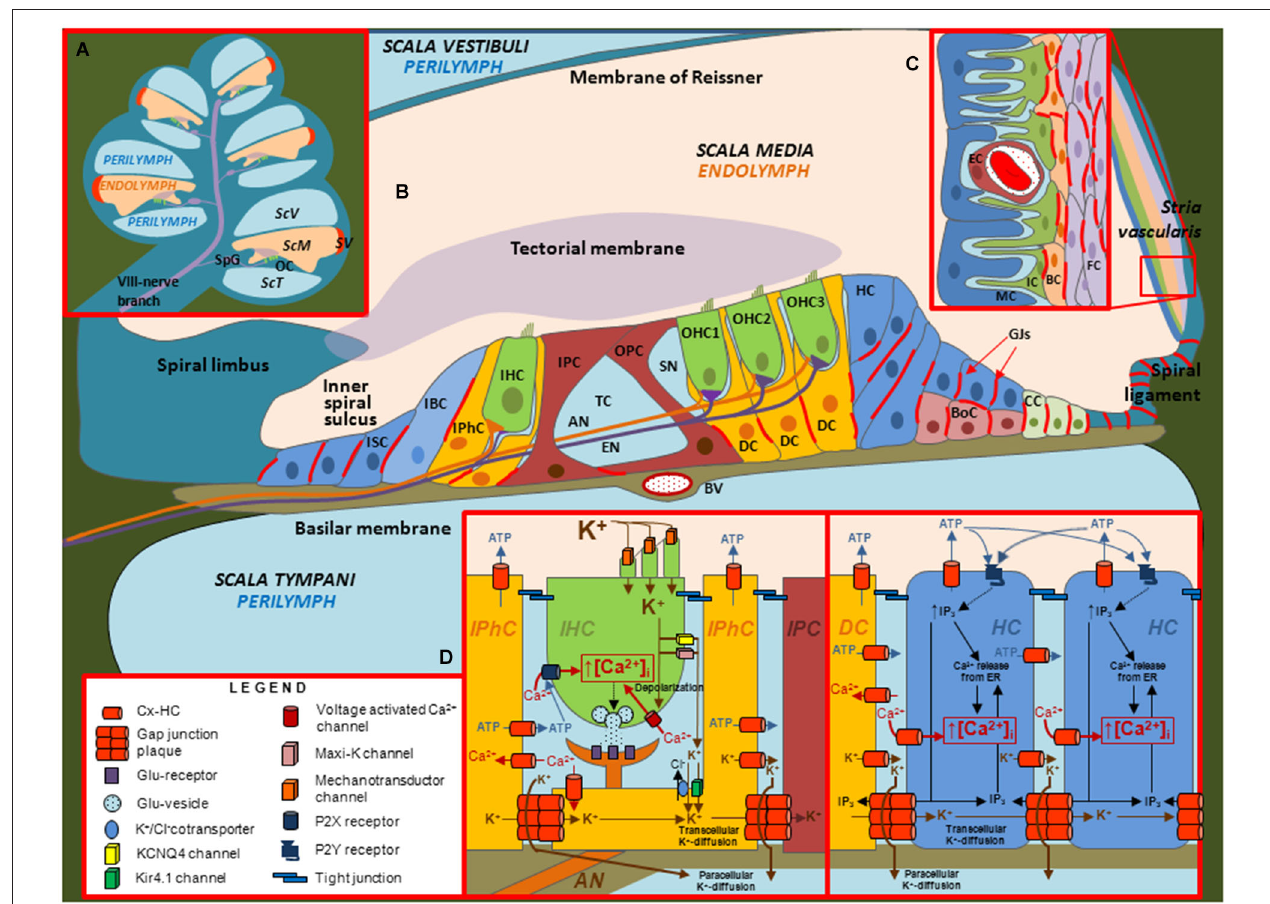
(BoC), Claudius cells (CC), Deiter’s cells (DC), Hensen cells (HC), Inner border cells (IBC), Inner pilar cells (IPC), Inner phalangeal cells (IPhC), Inner Sulcus cells (ISC), Outer pilar cells (OPC), space of Nuel (SN) and tunnel of Corti (TC). Inset (C) Structure of the Stria vascularis containing endothelial cells (EC), fibrocytes (FC), basal cells (BC), intermediate cells (IC) and marginal cells (MC). Inset (D) Putative roles of Cx channels in support cells. Cx HCs and GJ channels in support cells have been proposed to mediate the flux of K + , ATP, IP 3 and Ca 2 + across the membrane and between cells,